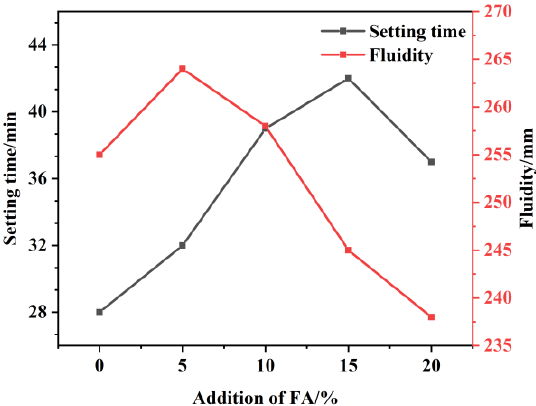
Figure 3. MPC pastes fluidity and setting time with varying fly ash contents.